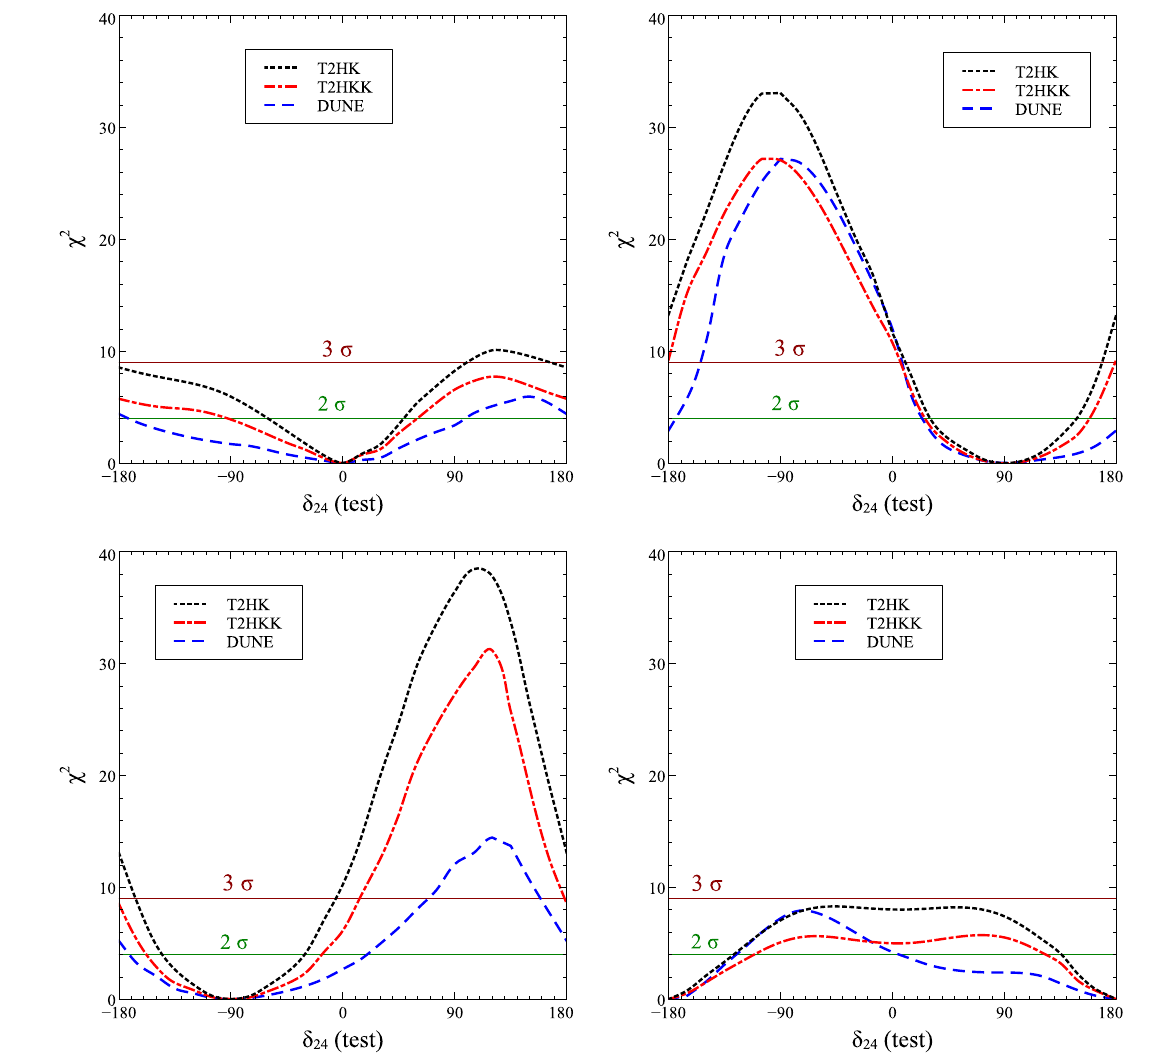
Fig. 1 The χ 2 vs. δ 24 (test). The black curves are for T2HK, the red curvess are for T2HKK and the blue curves are for DUNE. The top left panel is for δ 24 (true) = 0 ◦ , the top right panel is for δ 24 (true) = 90 ◦ , the bottom left panel is for δ 24 (true) = − 90 ◦ and the bottom right panel is for δ = 180 24 (true)